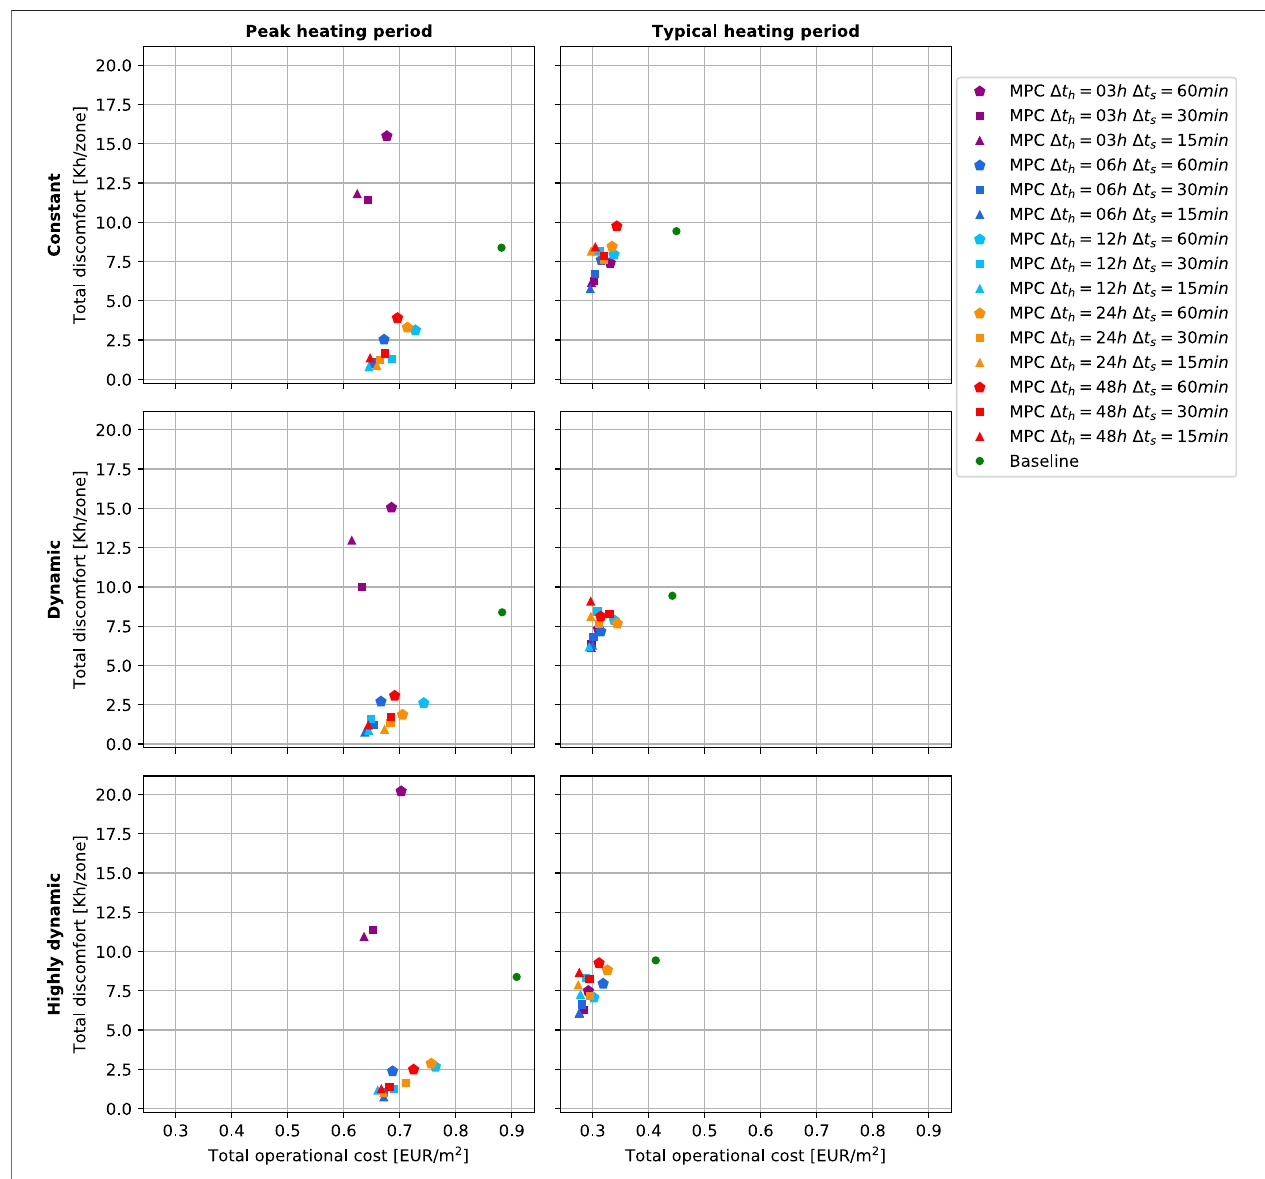
FIGURE 7| MPC performance results for different test case runs in each of the BOPTEST scenarios. The rows show the results for the same pricing scenario, and the columns for the same period scenario. The results are obtained for variations in control step Δ t s and prediction horizon Δ t h for the same MPC.